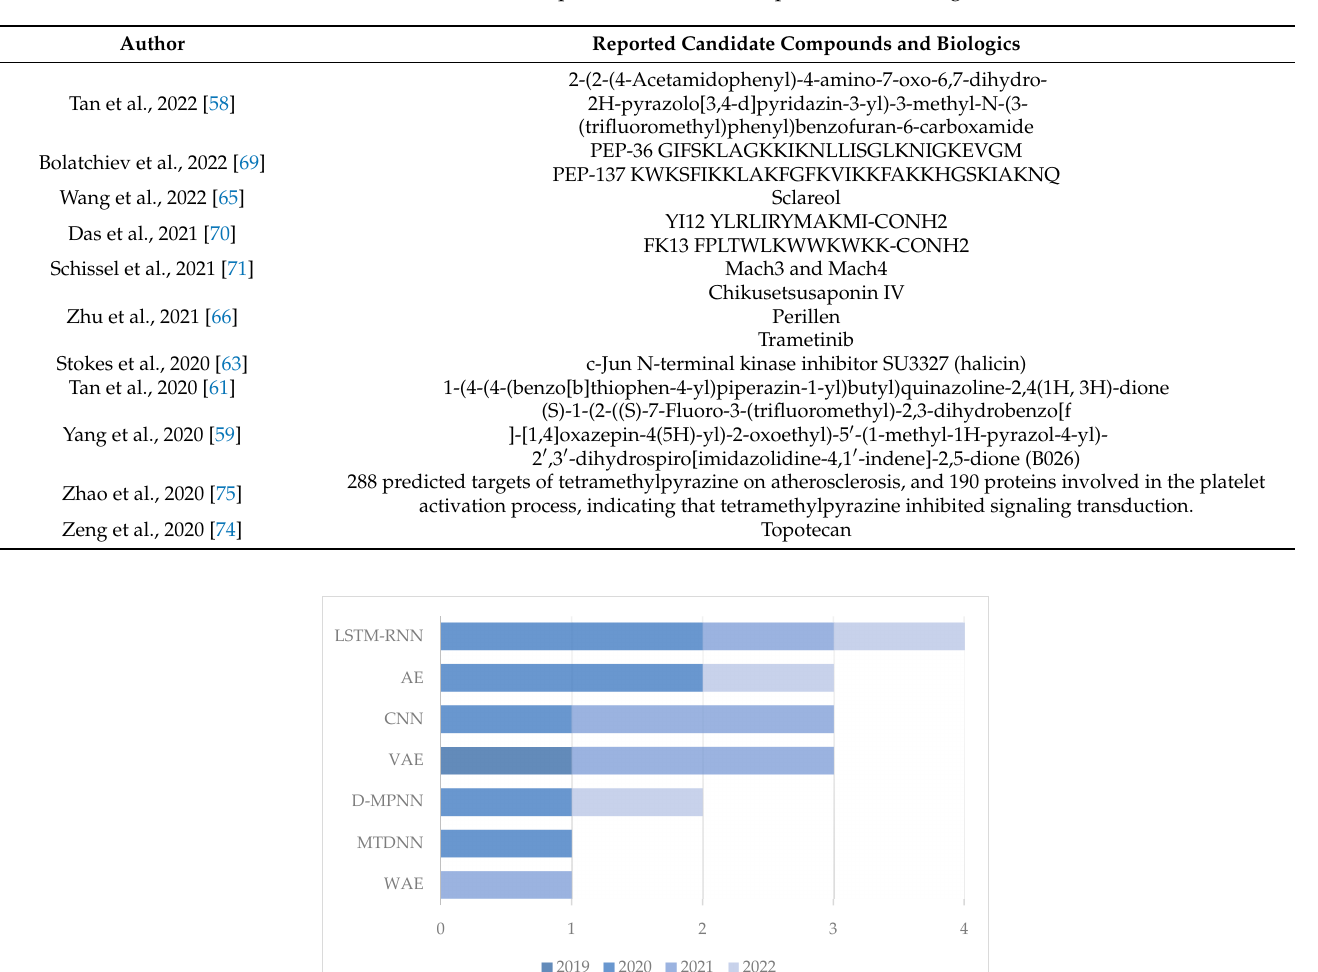
Table 5. A selection of reported candidate compounds and biologics in the studies reviewed.